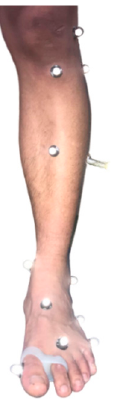
Figure 1. Illustration of hallux abduction manipulation between the hallux and other toes.